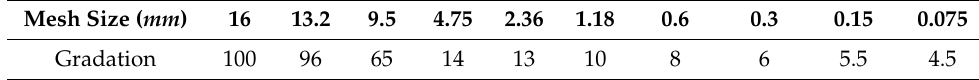
Table 6. Mineral Grading.